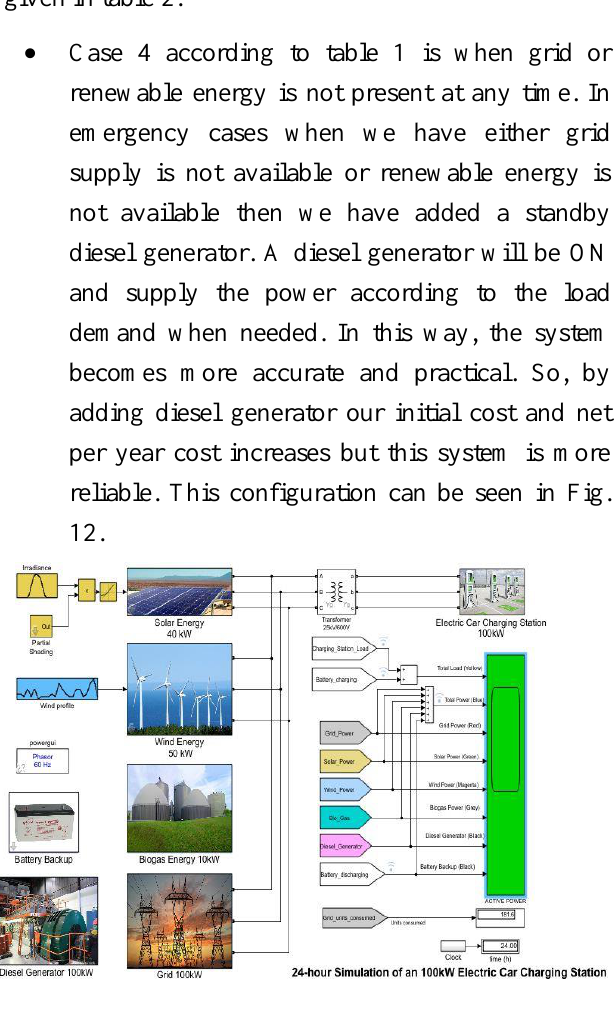
Fig. 11. Battery discharging Fig. 12. Results when diesel generator is added to proposed